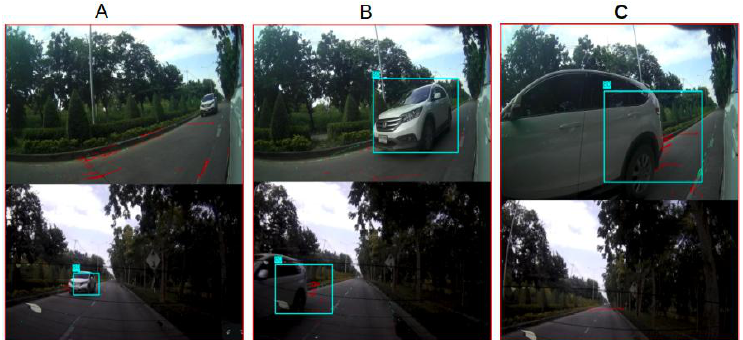
Figure 3. Example target tracking and camera switching. ( A ) Example image set I t containing one target in backward camera. ( B ) Example image set I t (cid:48) , t (cid:48) > t containing the same target in the backward and right cameras. The area of the bounding box in right camera is larger than that in the backward camera. At that point, tracking switches from the backward to the right camera. ( C ) The target has disappeared in the backward camera but is tracked in the right